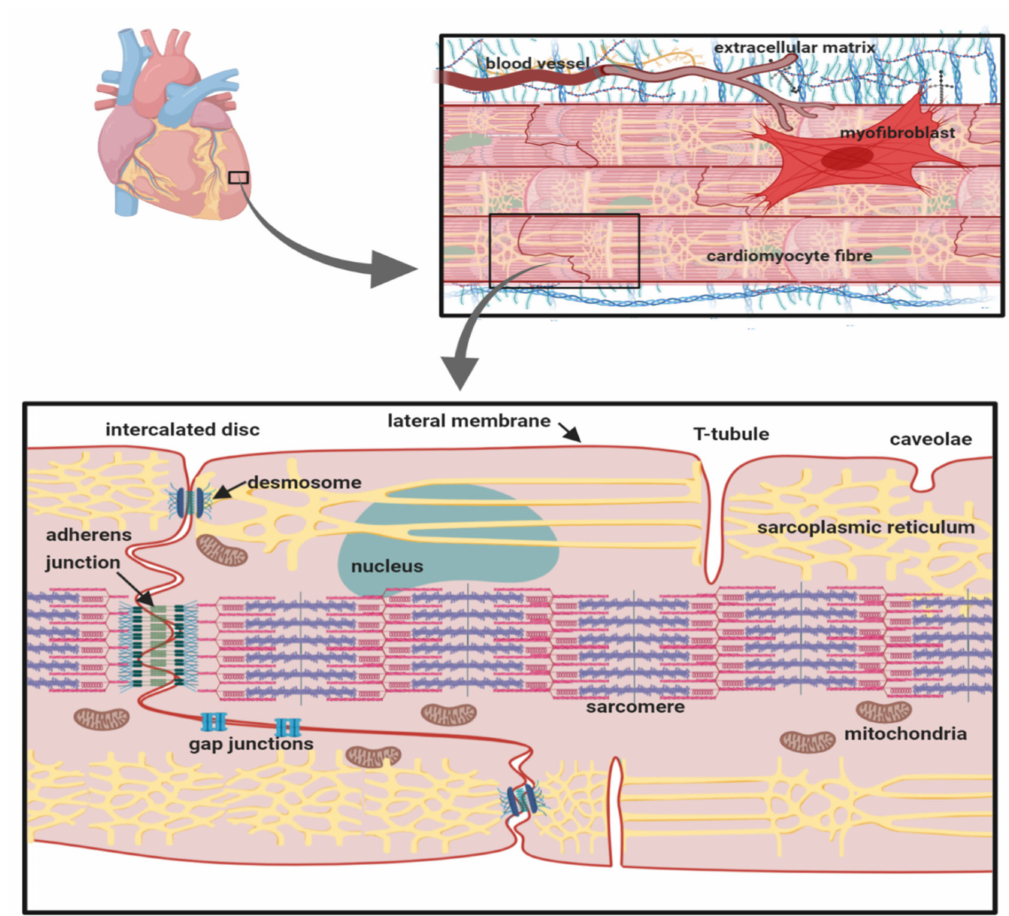
Figure 1. The cardiomyocyte: its anatomical and cellular context. The location of key organelles, membrane compartments and molecular components mentioned in the text are